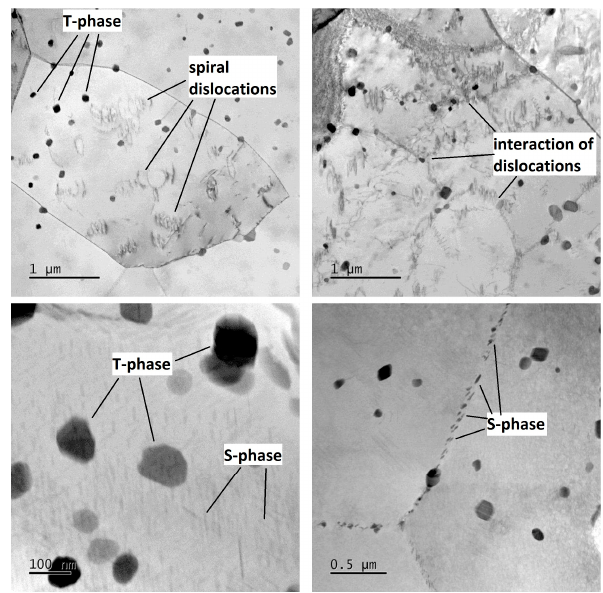
Figure 9. Micrographs of specimen W-0RS-160 at different magnification with marked dislocations, T-phases, and S-phases.